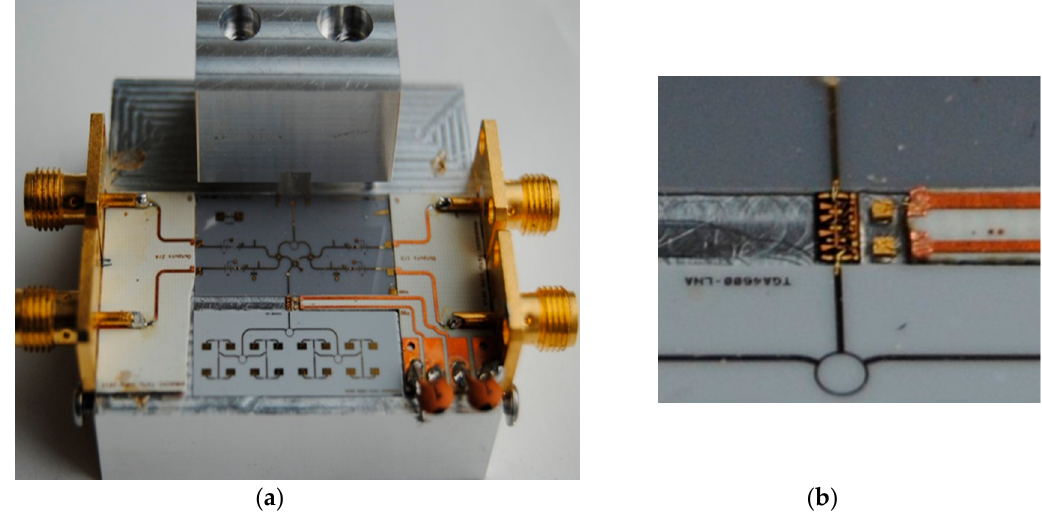
Figure 19. ( a ) V-band front-end with MMIC LNA in-between two separate MHMICs; ( b ) detail of LNA mounting.